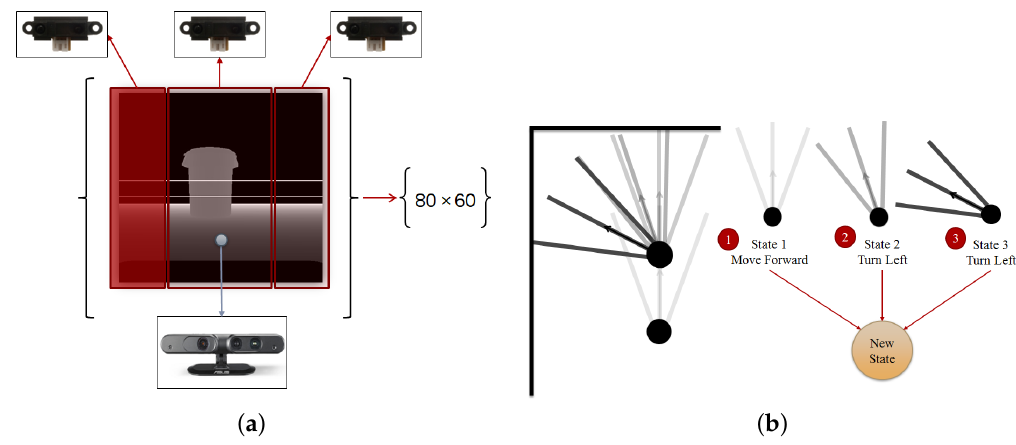
Figure 2. Sensor fusion and state generation. ( a ) Sensor fusion and state generation; ( b ); In order to enhance our robot capability, we combine several states and make a new state which in fact shapes our short-term memory (an example of memory with size three), adapted from